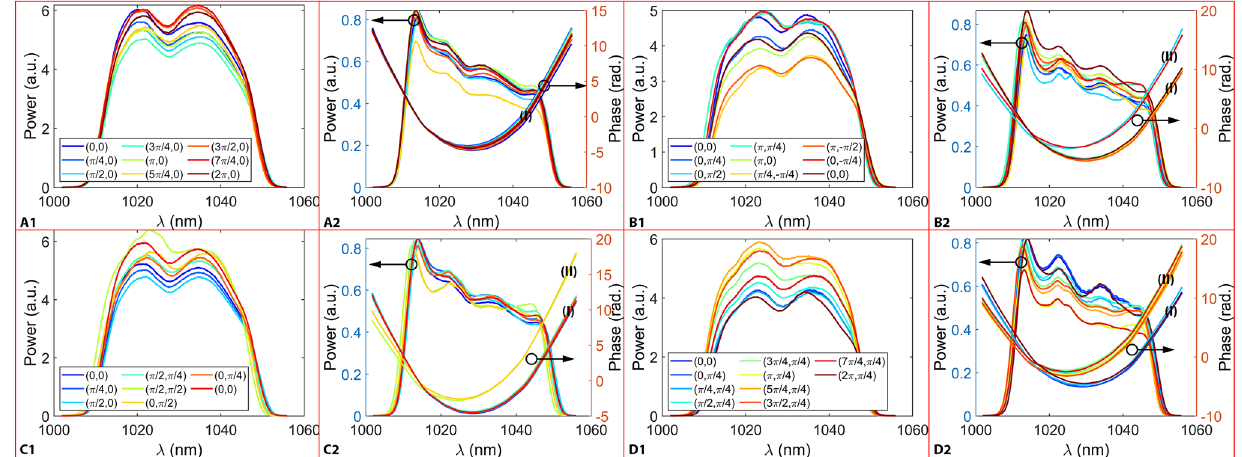
Figure 3. Spectrum and phase measurements of the pulse continually modulated along a closed path on the HOP sphere. ( A) : the equator (Path A); ( A1) : spectrum of sample pulse; ( A2) : spectrum and phase of reference pulse; ( B) : the circle of 0° and 180° longitude (Path B); ( C) : the polar triangle between (0,0), (π/2,0) and (0,π/2) (Path C); D: the circle of 45° latitude (Path D). ( B–D) follow the same description as A. Every specific spherical coordinate ( (cid:31) , (cid:30) ) in the figure legend denotes a measurement point. I and II denote the two spectral phase zones containing the radial and the north pole state, respectively.